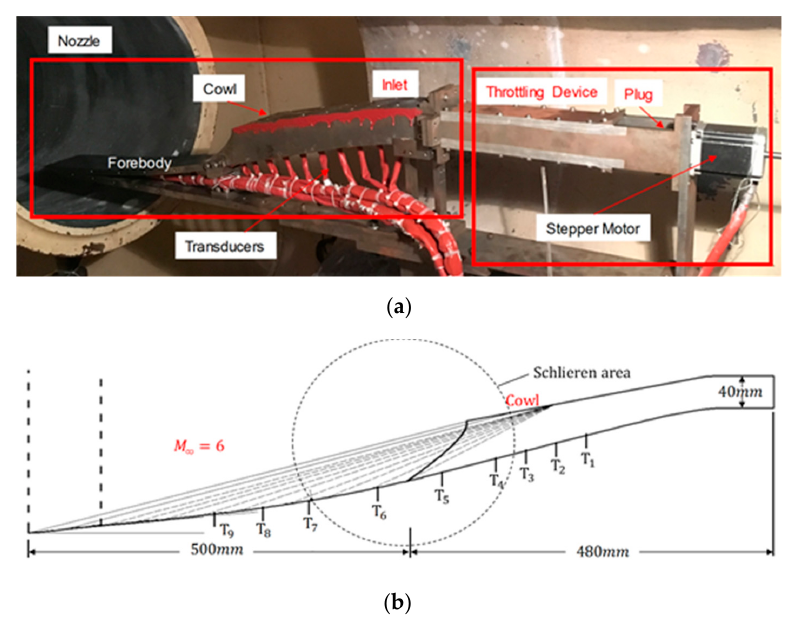
Figure 2. Test model of inlet and throttling device (( a ) physical map; ( b ) schematic diagram).